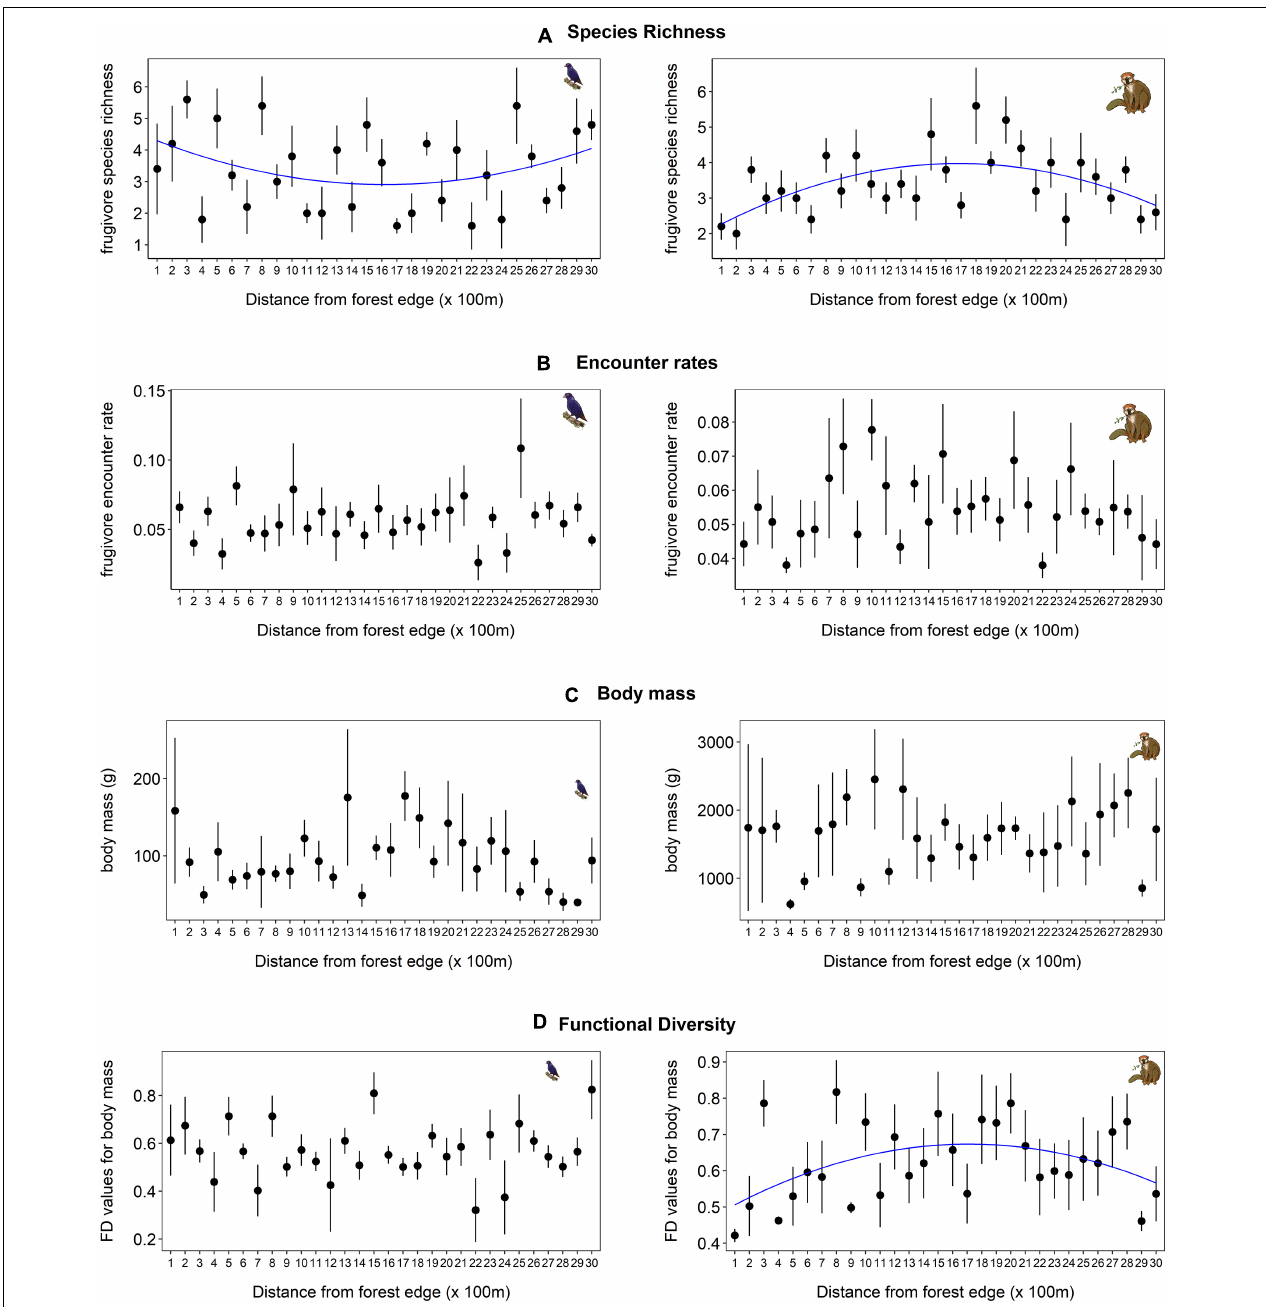
FIGURE 1 | Species richness (A) , encounter rates (B) , body mass (C) , and functional diversity measures of size variation (D) of frugivorous birds (left) and lemurs (right) along an edge-interior gradient in transects of 3,000 m. Circles represent mean values across transects, whiskers indicate standard deviations. The blue line corresponds to the fit of a significant quadratic polynomial regression. Taxa illustrations by Finaritra Randimbiarison.